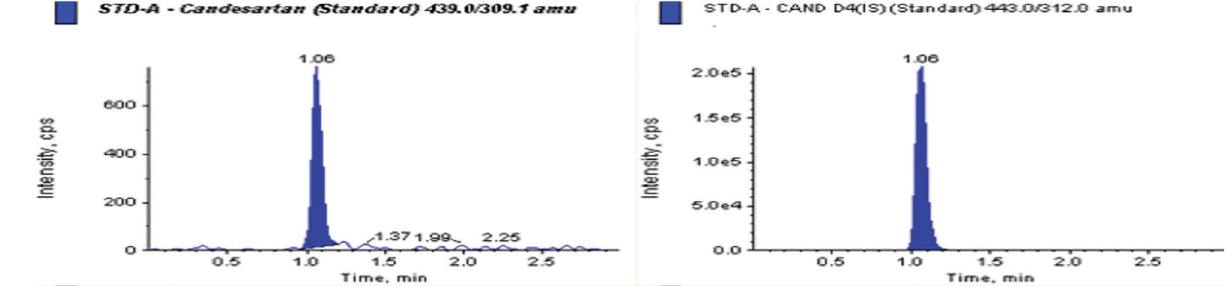
FIGURE 7 - Representative chromatogram of standard CAN (LLOQ sample).